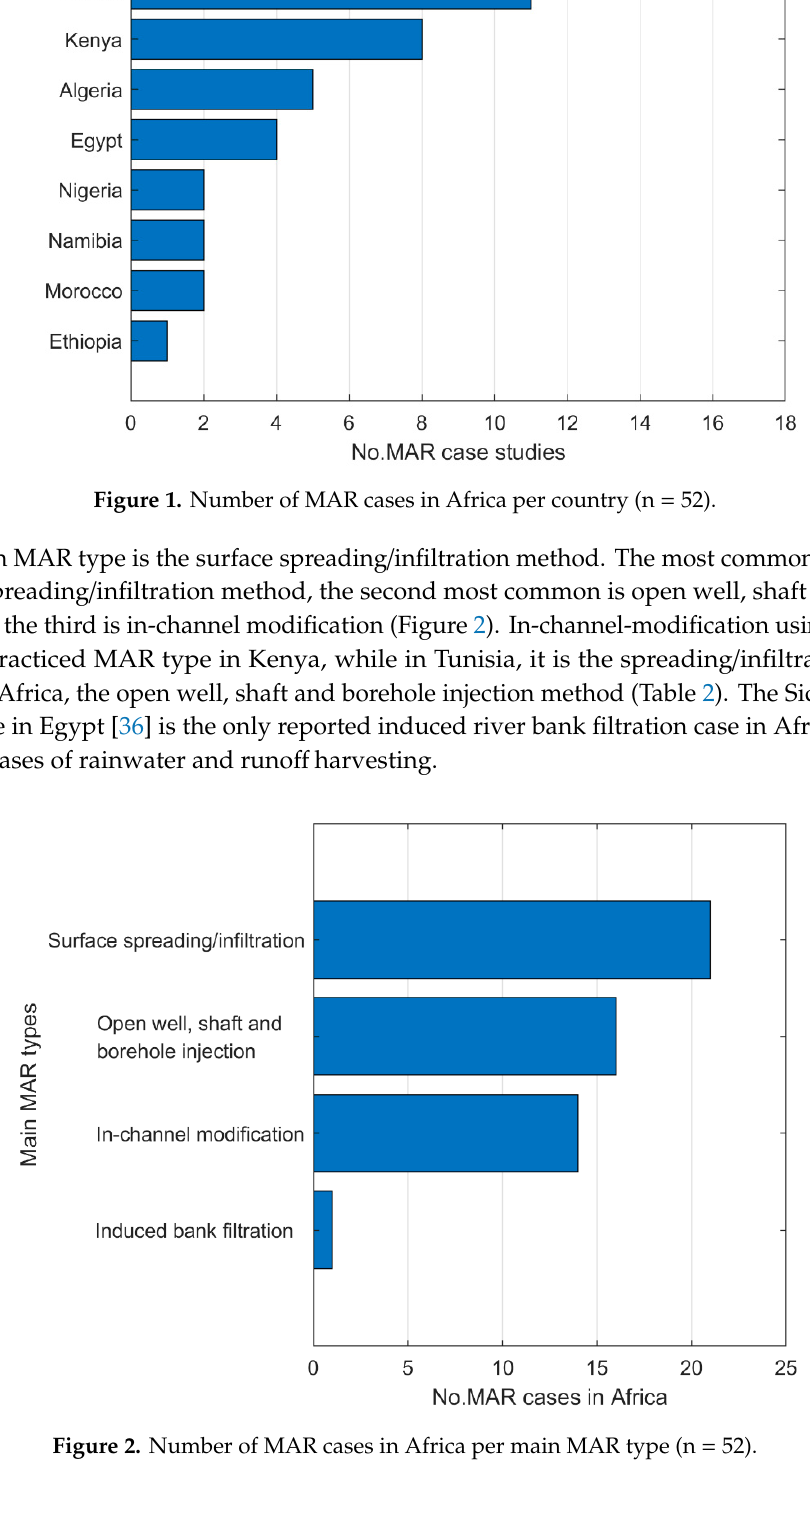
Figure 2. Number of MAR cases in Africa per main MAR type (n = 52).